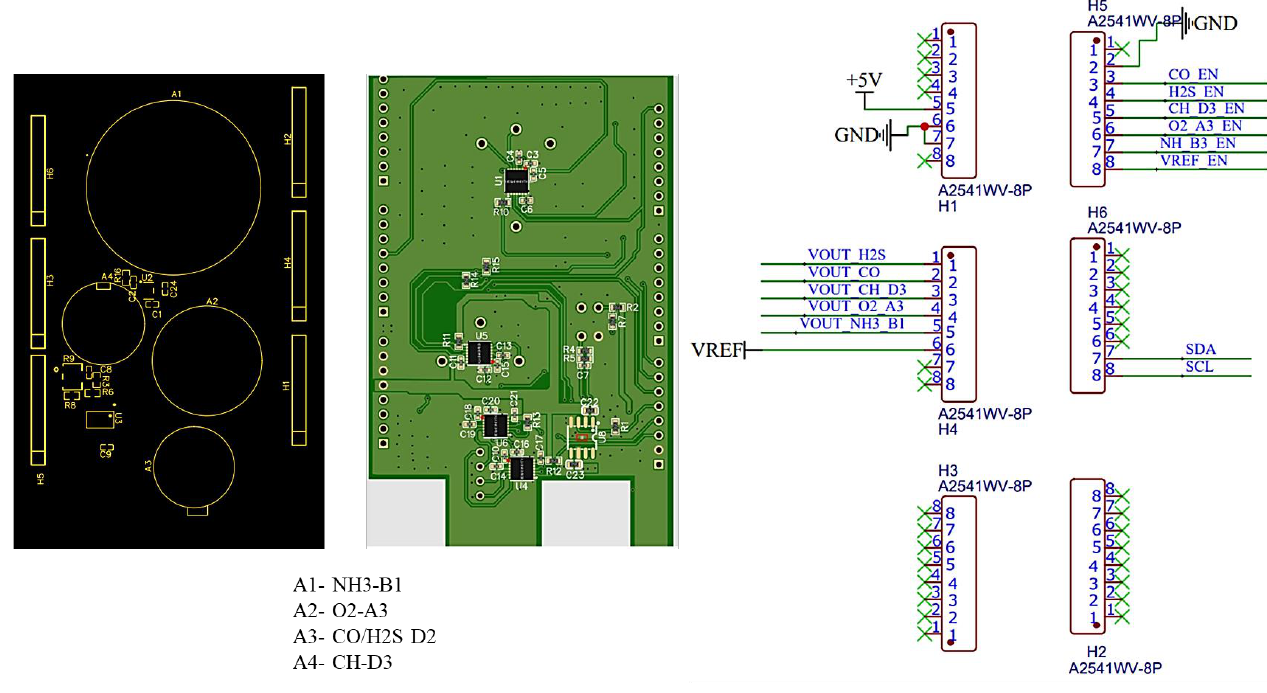
Figure 5. Designed gas sensor unit and connections with Arduino Mega. The sensor unit was maintained inside a 3D mold and placed on the front side of the helmet. Workers were directly exposed to hazardous gases near their breathing zones.